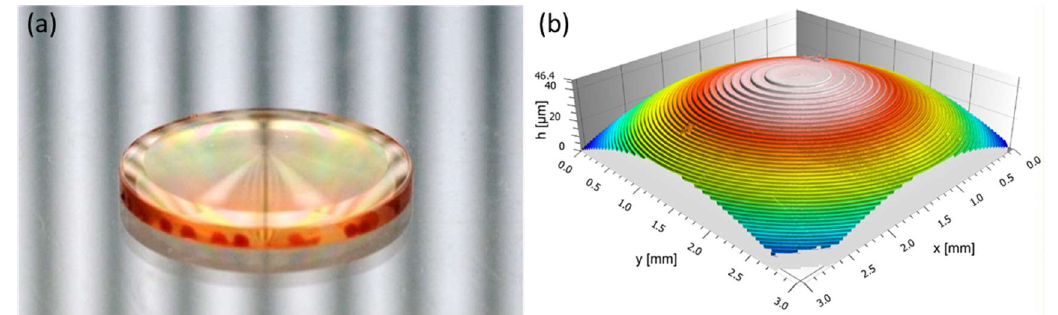
Figure 12. ( a ) Curved glass master with diffractive structure produced by laser direct writing (LDW), ( b ) confocal measurement of the diffractive structure. Reproduced with permission from [133].